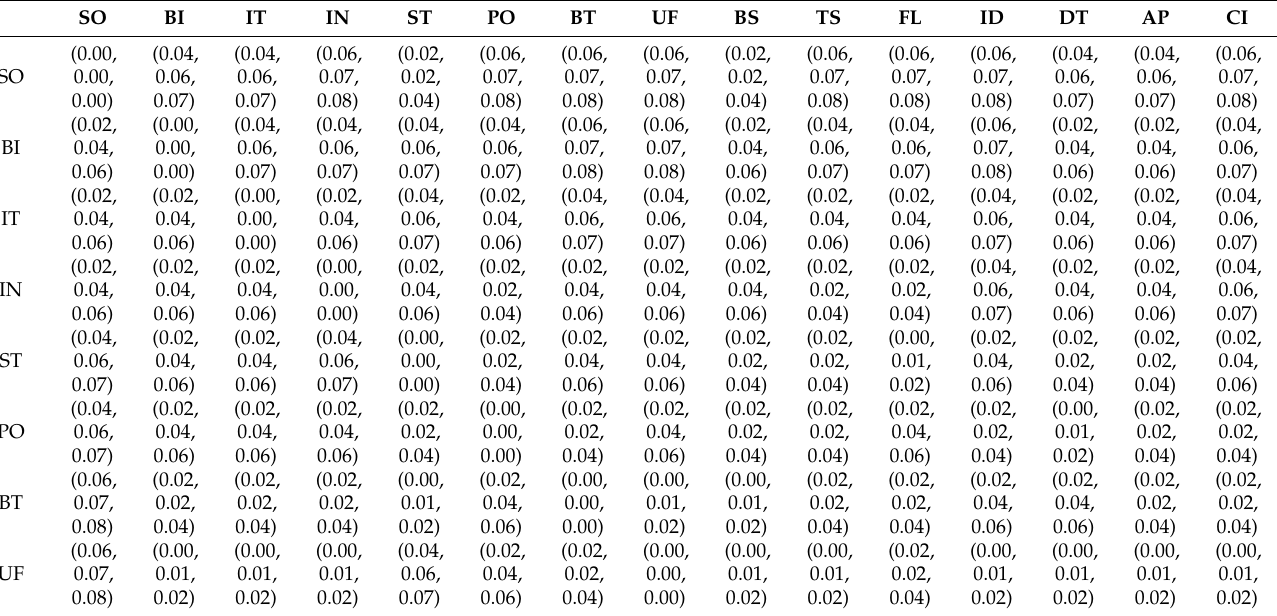
Table 9. Normalized fuzzy direct relation